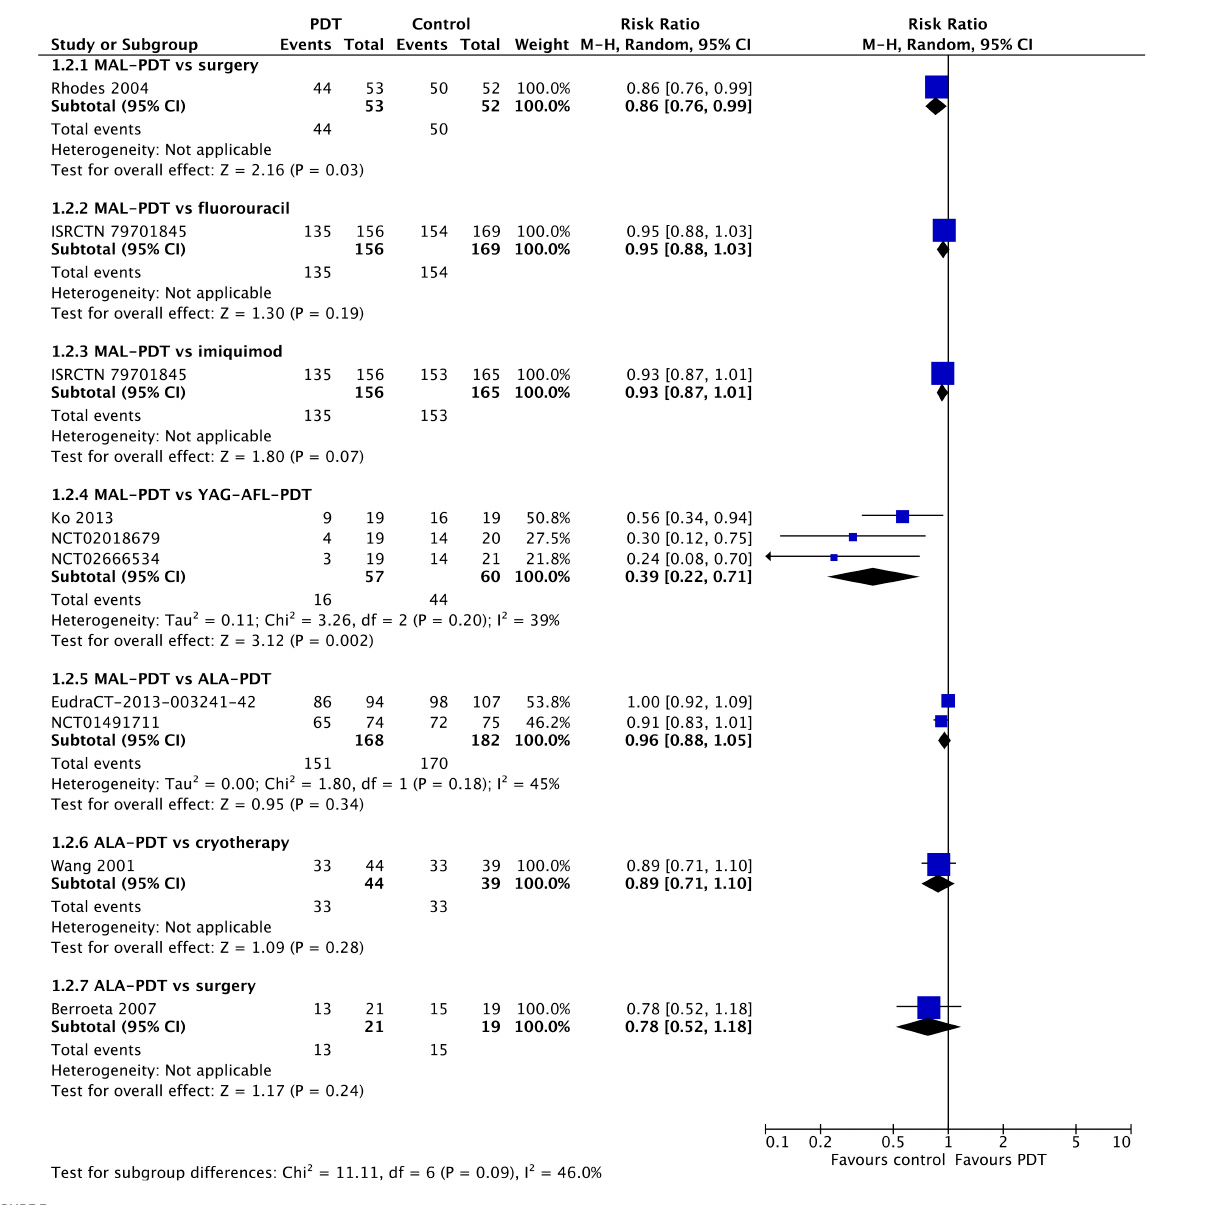
(ALA) PDT, erbium: yttrium-aluminum-garnet ablative fractional laser-assisted (YAG-AFL) PDT, hexaminolevulinic (HAL)